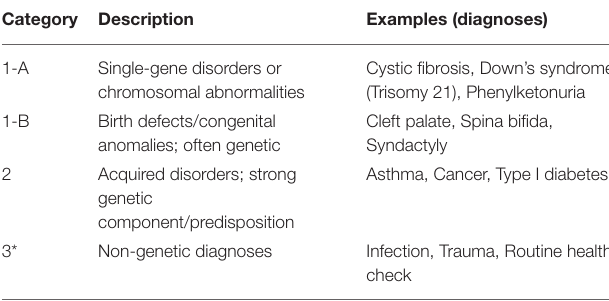
TABLE 1 | Description of genetic